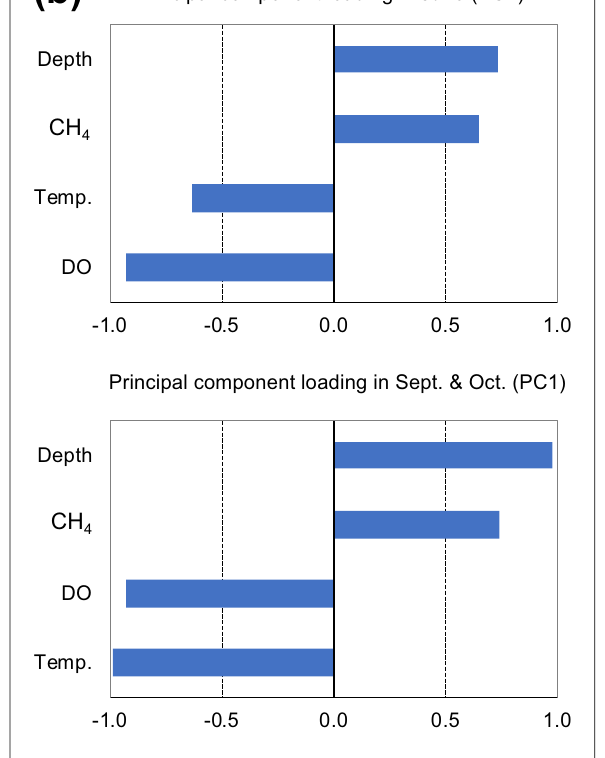
Fig. 3 a Cross‑section of Lake Suwa and water column profiles measured in September 2018. Here, we note that planktonic cyanobacteria move toward a lower water layer at night and rise to the surface layer before dawn (Reynolds 1987). b Principal component loading for the water depth (cm), water temperature (°C), dissolved oxygen (mg/L), CH 4 (mmol/L) in the sampling site at Lake Suwa for early summer season (June in 2018 and 2019, n autumn season (September to October in 2018 and 2019, n